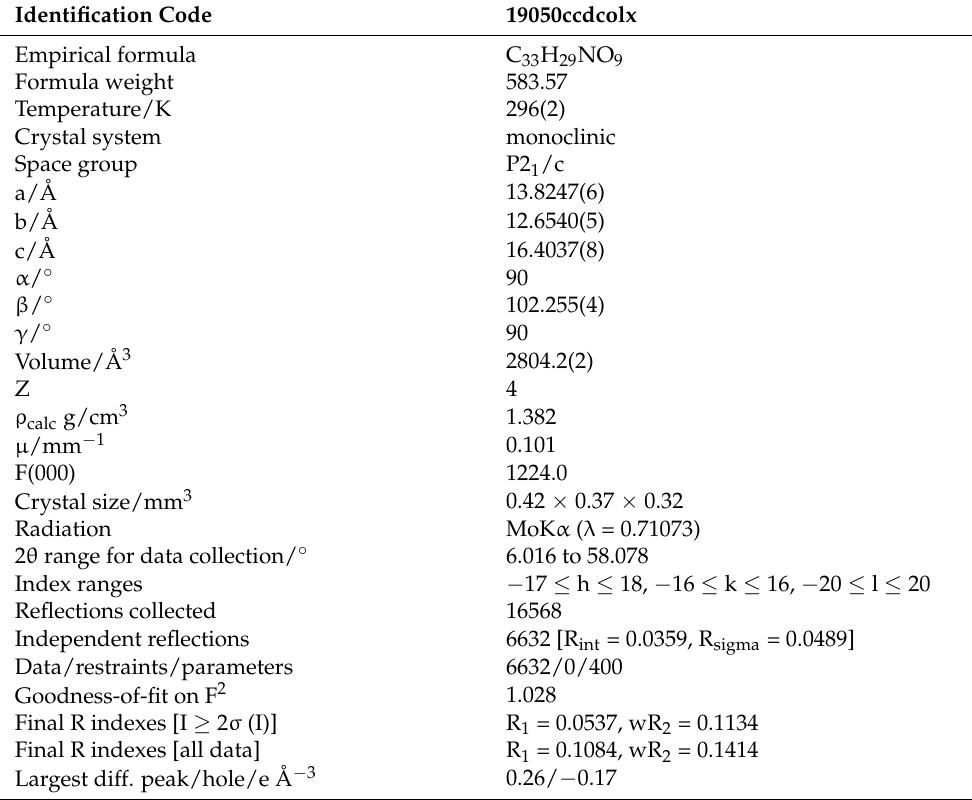
Figure 1. Ortep diagram where thermal ellipsoids were drawn at 50% probability level. Table 3. Crystal data and structure refinement for dicoumarol 4